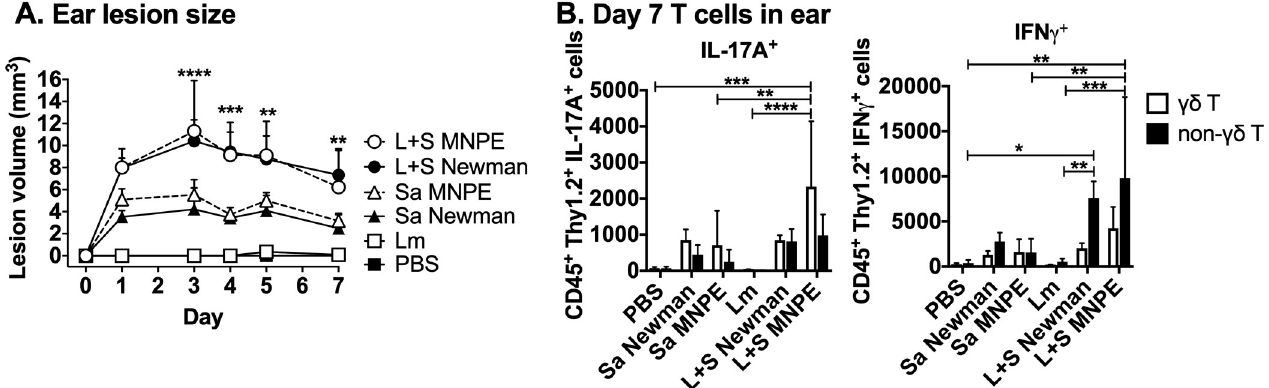
Fig 7. Coinfection with S . aureus MNPE, a USA200 TSST + clinical strain, recapitulates early L . major-S . aureus Newman lesion exacerbation and cytokine production. Mice were injected intradermally in the ear with phosphate buffered saline (PBS), L . major (Lm), S . aureus Newman (Sa Newman), S . aureus MNPE (Sa MNPE) or co-inoculated with L . major and either S . aureus strain (L+S Newman or L+S MNPE) and ear lesion volume was measured for 7 days. On day 7 p.i., single cell suspensions from the ears were obtained, treated with BFA, PMA, and ionomycin for 4–5 hours, stained for surface markers and intracellular cytokines, and analyzed by flow cytometry. (A) Lesion volume of ears coinfected with L . major and S . aureus MNPE compared to those coinfected with S . aureus Newman MSSA. (B) IL-17A + or IFN γ + γδ (CD45 + Thy1.2 + γδ TCR + ) and non- γδ (CD45 + Thy1.2 + γδ TCR - ) T cell numbers in ears. Data represent the mean ± SD of one experiment with 5–6 mice/group. Lesion size data are representative of two independent experiments. � p < 0.05, �� p < 0.01, ��� p < 0.001, ���� p < 0.0001 by one-way ANOVA with Tukey’s